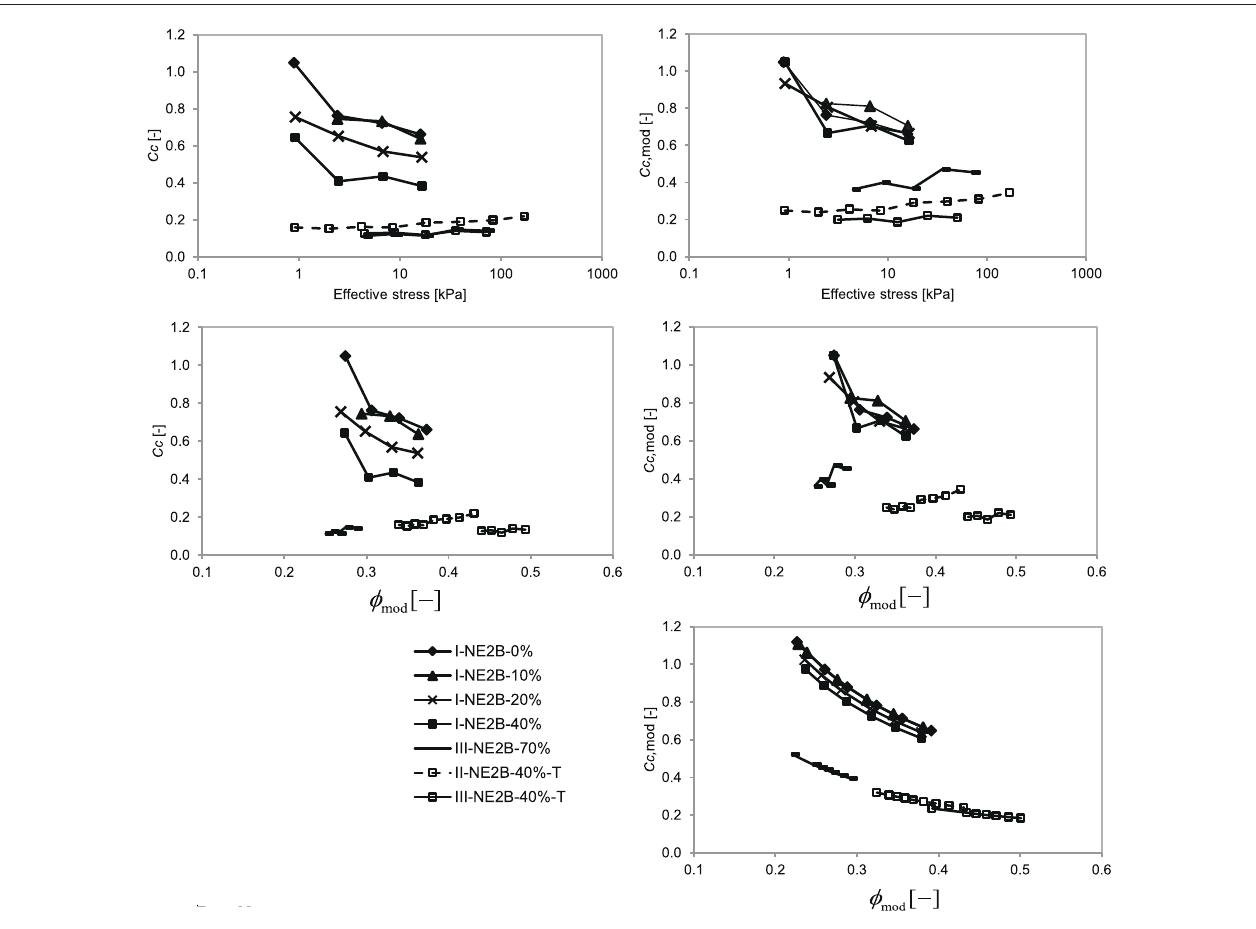
FIGURE 4 | (A,C) Compressibility coef fi cient C c without correcting for the presence of sand. (B,D) C c ,mod calculated with the corrected void ratio. (E) C c ,mod calculated following fractal theory using material parameters with proposed Eq. 6 as function of ϕ mod .